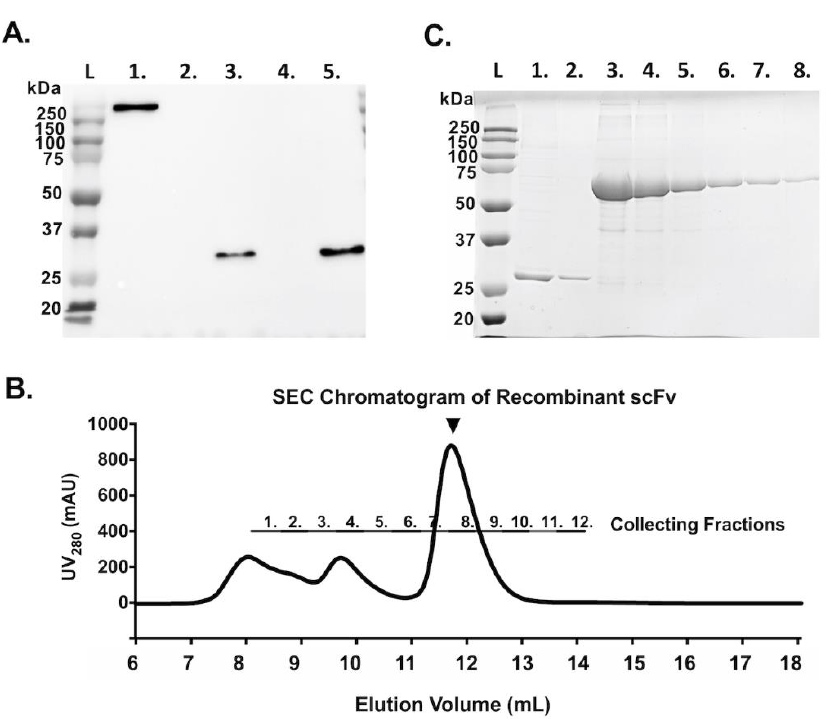
Figure 2. Production of recombinant scFv . ( A ) The expression of recombinant scFv in Expi293F™ cells was confirmed by Western blotting. The expected size of the recombinant scFv is approximately 30 kDa. Lane 1: The His-tagged PEDV S protein was used as a positive control. Lane 2: The cell lysates from non-transfected HEK 293 cells. Lane 3: The cell lysates from scFv-transfected cells. Lane 4: The supernatant from non-transfected cells. Lane 5: The supernatant from scFv-transfected Expi293F™ cells. L: Protein ladder. ( B ) Size-exclusion chromatogram of the recombinant scFv purified by IMAC. UV280 detected the protein content in mAU. The black arrowhead indicates the expected major peak of the scFv. ( C ) The expression and purity of the purified scFv in Expi293F™ cells. Lane 1: two-fold dilution of the purified scFv. Lane 2: 10-fold dilution of the purified scFv. Lanes 3–8: two-fold serial dilutions of standard BSA from 2 mg/mL to 0.0625 mg/mL.